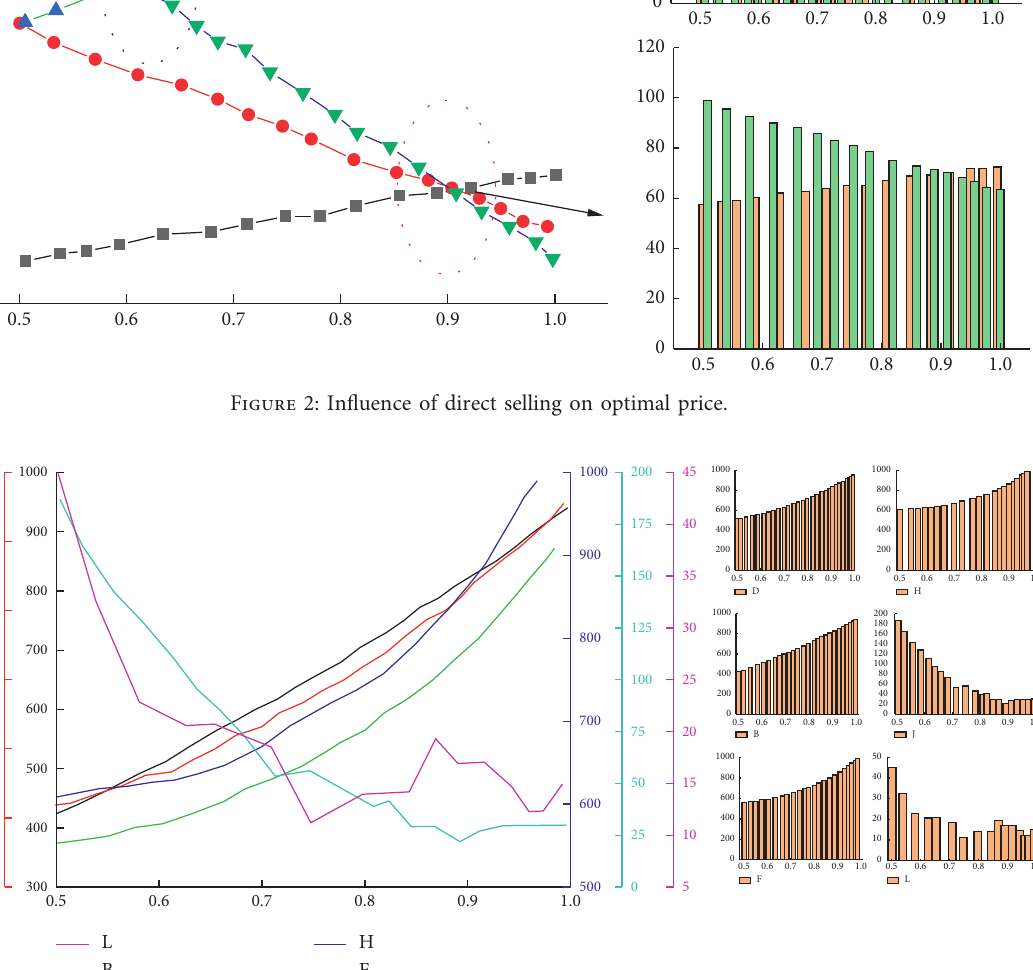
Figure 3: Influence of direct selling on optimal